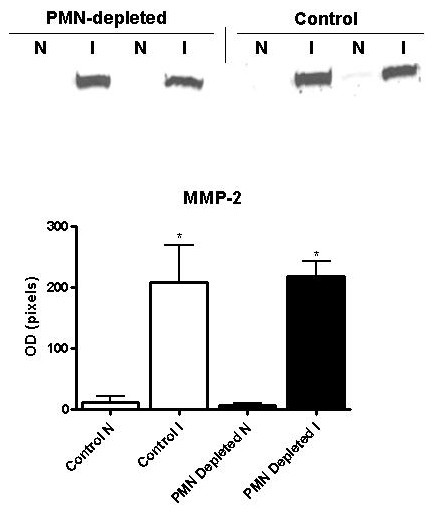
MMP-2 protein expression is increased in ischemia. (A). Representative immunoblot demonstrating changes in MMP-2 protein expression in ischemic hemispheres from control and PMN-depleted animals. (B) Densitometric analysis of immunoreactive bands indicates that MMP-2 protein is increased in ischemia and is unchanged by neutrophil depletion. (*p < 0.05 vs contralateral hemisphere, saline n = 6, PMN n = 4).